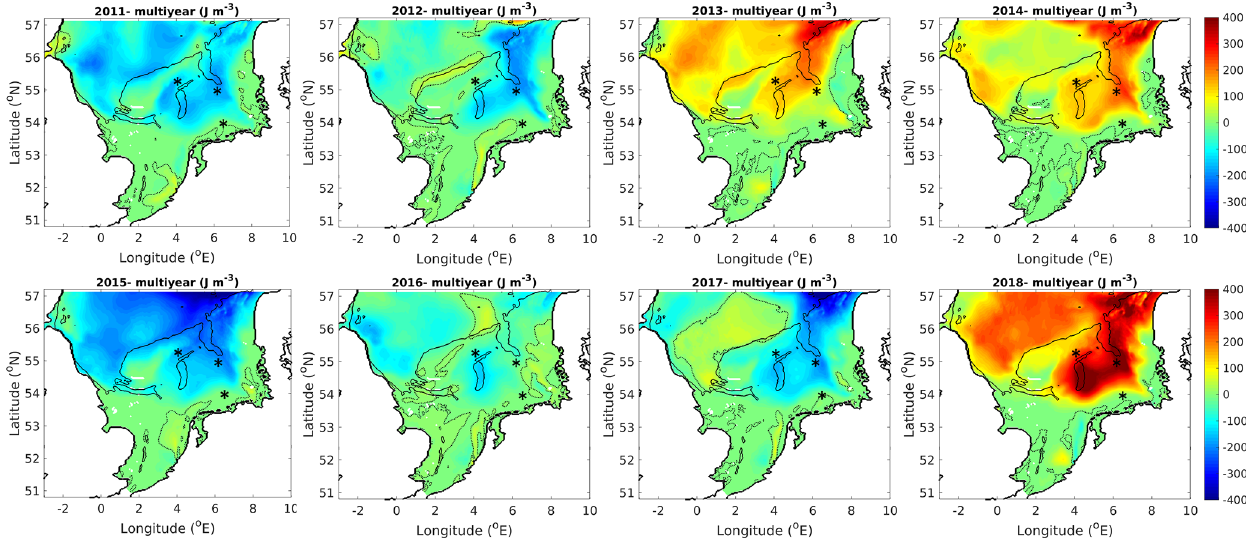
Figure 7. Difference in the potential energy anomaly (Jm − 3 ) averaged over 3 months (June, July and August) between a specific year and the multiyear mean. The dashed line indicates φ = 50Jm − 3 . Thin black lines indicate the location of the 50m isobath.